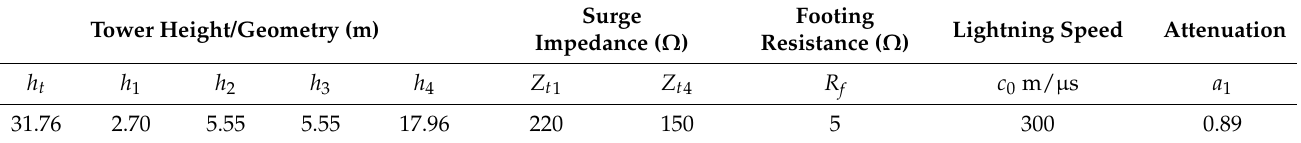
Figure 5. Norton circuit. Table 3. Tower model parameters for 275 kV system voltage [26].